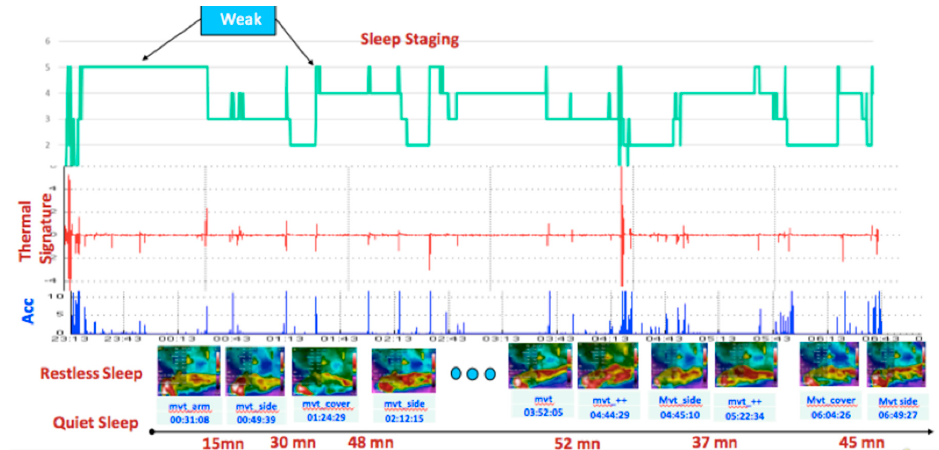
Figure 8. An example of the classification of the sleep obtained using only the data of the thermal signature. The algorithm used is K-means by choosing five clusters. Below is a representation of